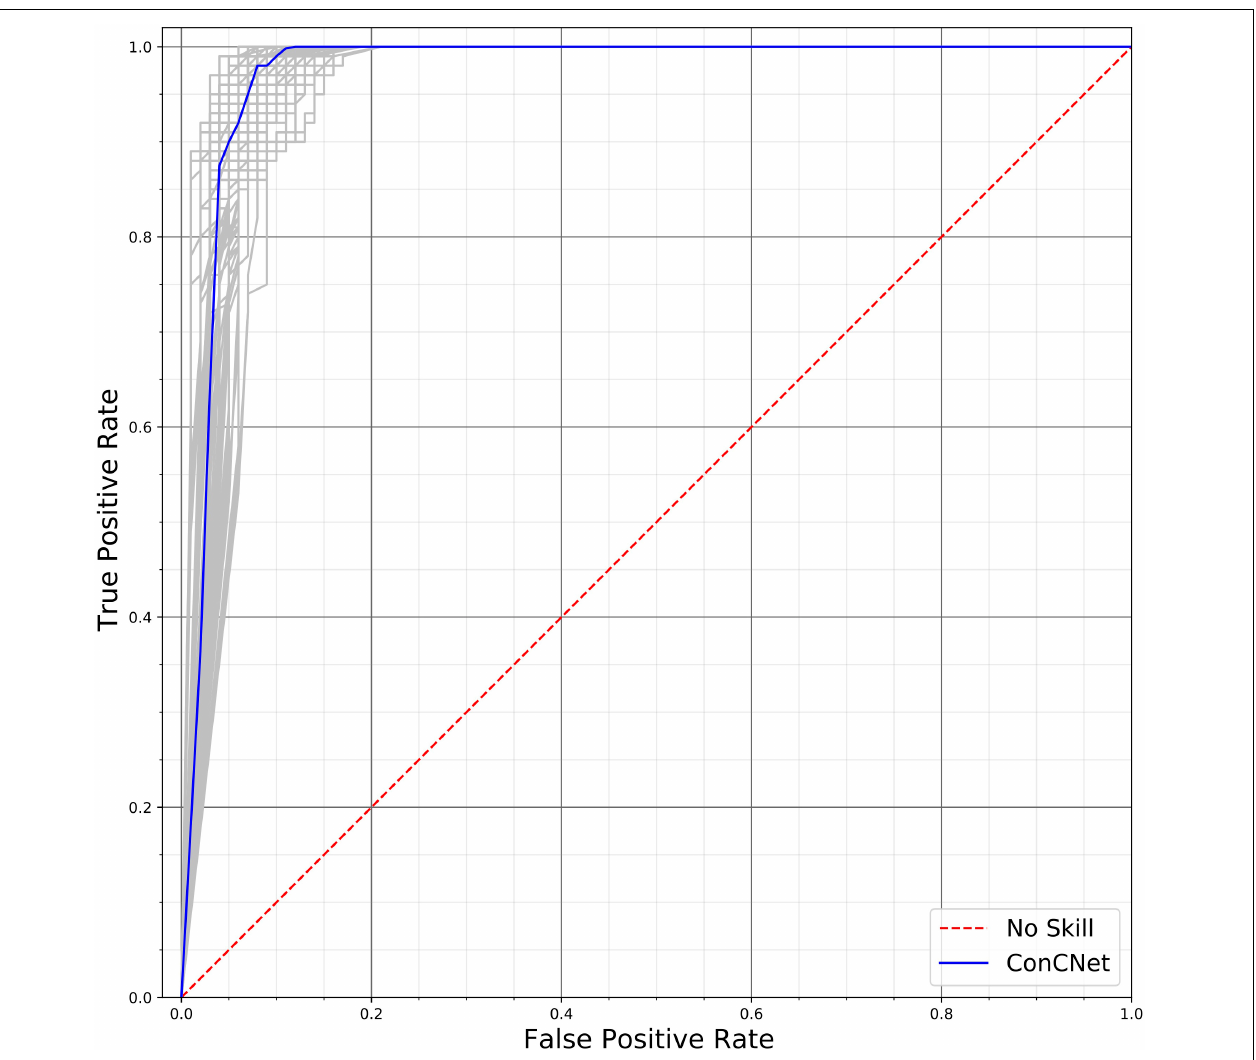
FIGURE 10 | Receiver operating characteristic (ROC) curves for the 100 ConcNet 3 networks used in MCCV. The gray curves show the results for each of the 100 networks and the blue curve shows the median. The ensemble median Area Under the Curve (AUC) is 0.971 (the 25% and the 75% percentile are 0.964 and 0.978,